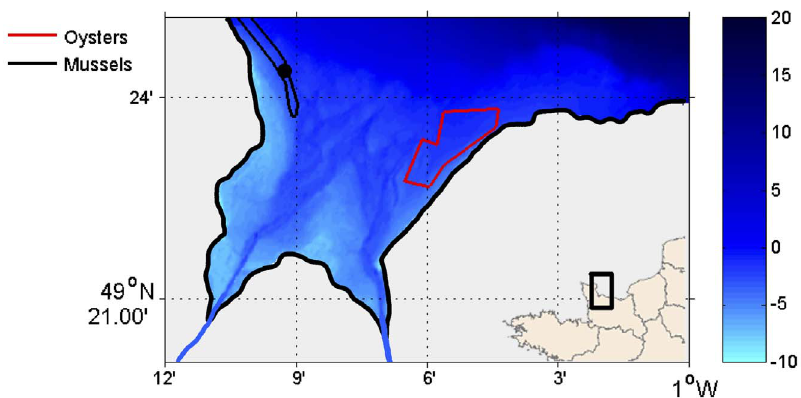
Figure 1. Location of the study area in the Bay of Veys.